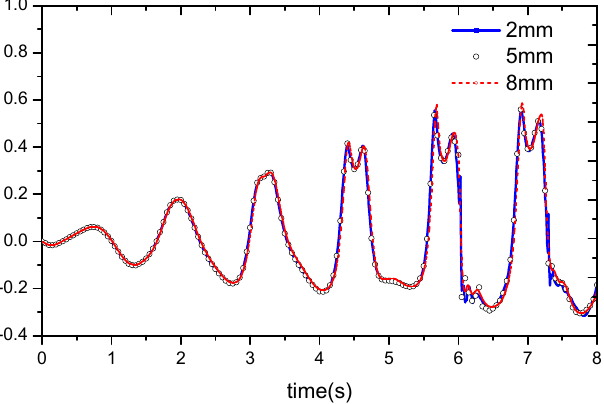
Figure 5. The comparisons of the pressure recorded at P1 in the cases with different mesh sizes.